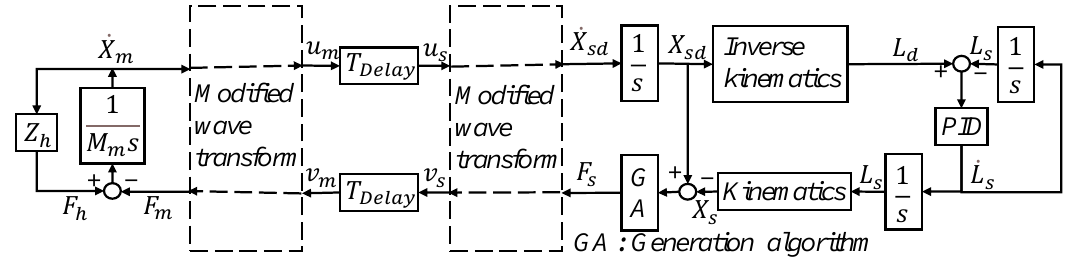
Figure 7. Designed teleoperation control scheme for